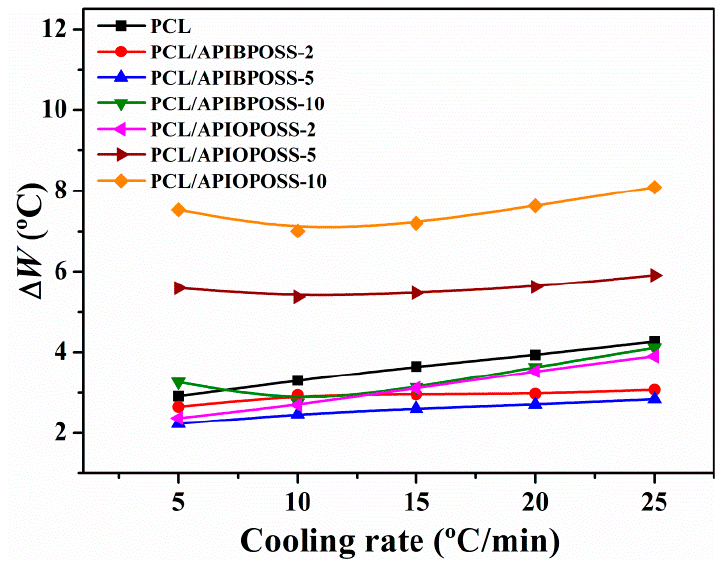
Figure 3. Crystallization peak width at half maximum as a function of cooling rate for PCL and PCL/POSS nanocomposites.